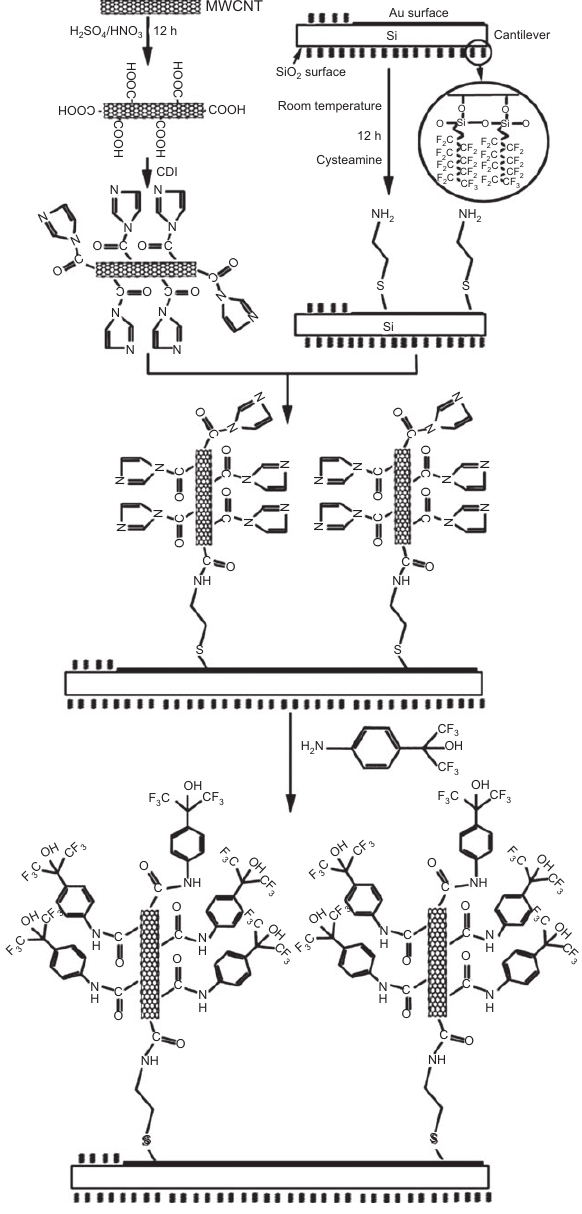
Figure 6 The entire process of the MWCNTs for material modifi- cation, immobilization on Au surface at the cantilever end, and TNT-sensitive functionalization. Reproduced with permission from Xu et al. (2010)